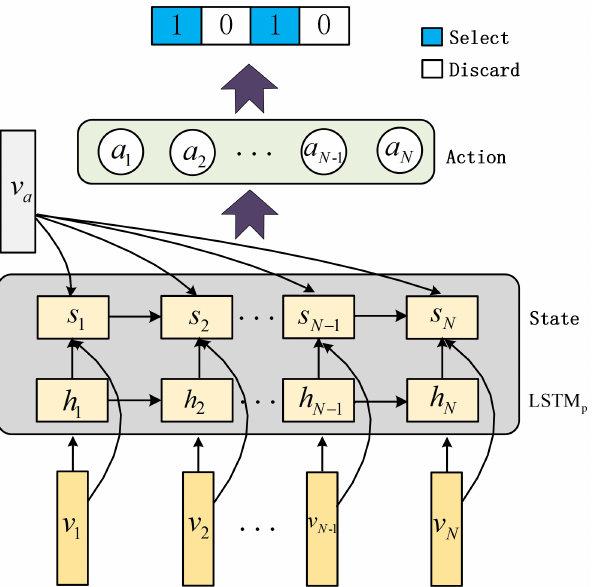
Figure 2. The framework of our proposed token selector, i.e., Reinforced Aspect-guided Token Selector